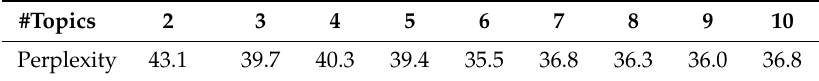
Table 8. Perplexity vs #topics of the major cluster for the gunshot in West Lafayette,